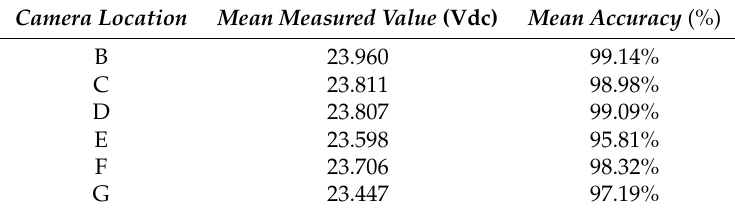
Figure 20. The effective range to place the camera in to read the A-meter is roughly confined within the zone bounded by the edges among B-C-D-E-F-G-B. If the camera is placed outside this region (e.g., H and I), the reading of the A-meter will fail. Table 12. Statistical results for the camera located at B, C, D, E, F, and G of the effective range drawn in Figure